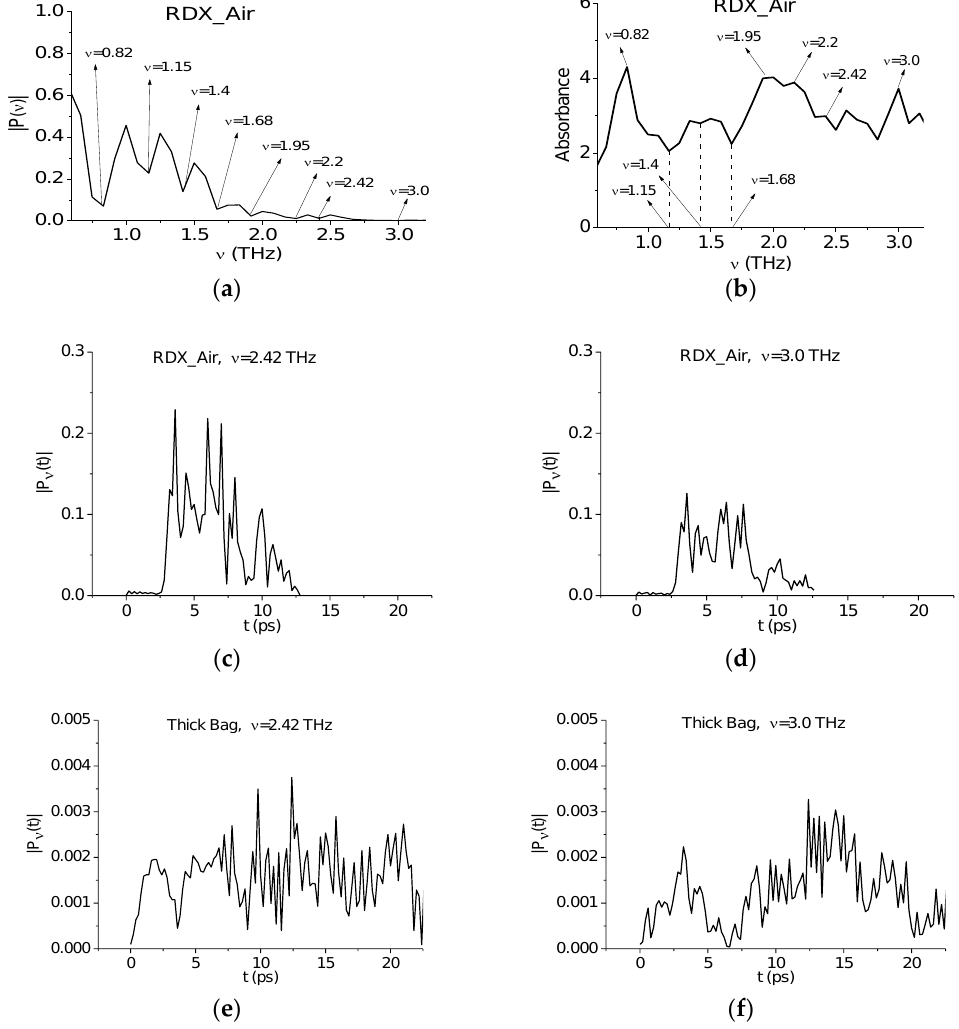
Figure 6. Fourier spectrum of the RDX_Air THz signal ( a ) and absorbance ( b ) in the frequency range ν = [0.6, 3.2] THz; dynamics of spectral lines of the RDX_Air ( c , d ) and Thick Bag ( e , f ) signals at frequencies ν = 2.42 THz ( c , e ); 3.0 THz ( d , f ).